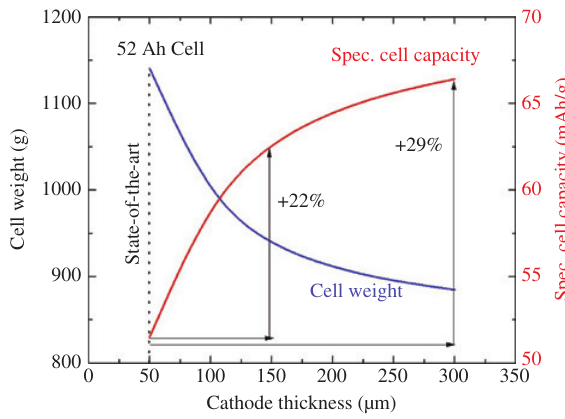
Figure 6: Impact of NMC cathode film thickness on cell weight and specific cell capacity (state-of-the-art 52 Ah cell: footprint area 21 × 24 cm 2 , cathode film thickness 50 μ m, 37 double-sided cath- odes, 36 double-sided anodes, 2 single-sided anodes, 39 separa- tors, and 204 ml electrolyte [26]).